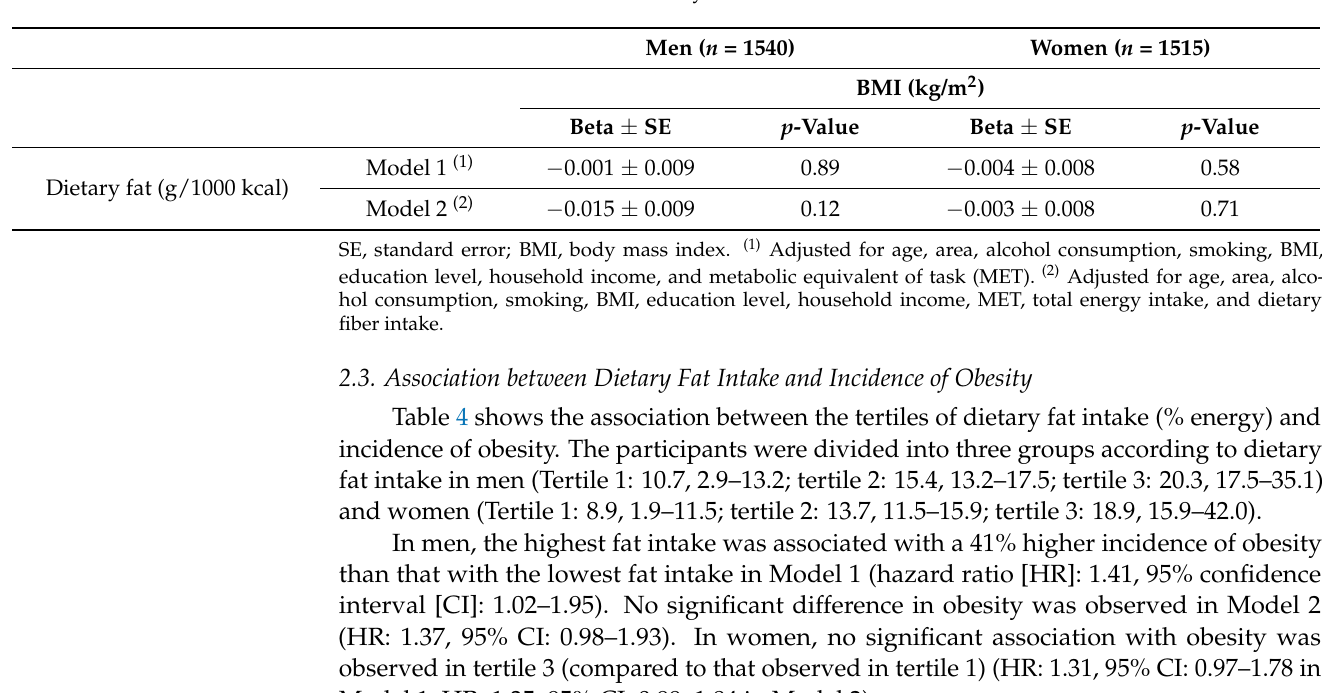
Table 3. Association between dietary fat intake and